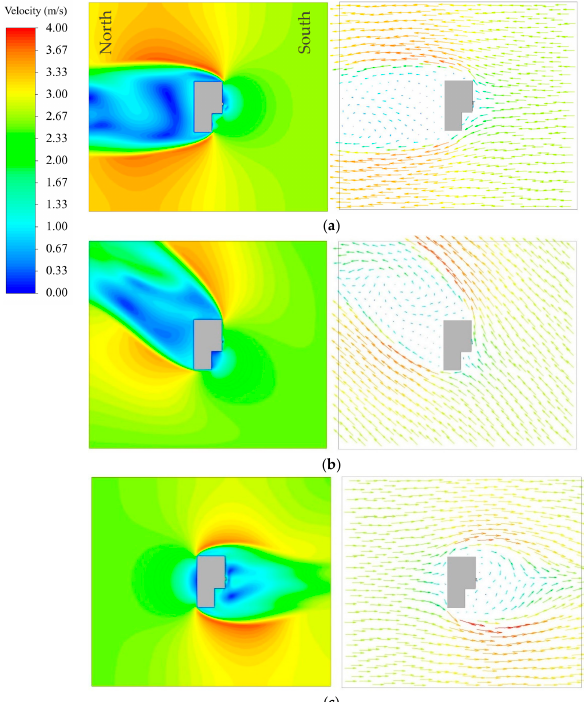
Figure 7. Contour of velocity magnitude and velocity vector (Plan-EFGH): ( a ) Case 1; ( b ) Case 4; ( c ) Case 7.